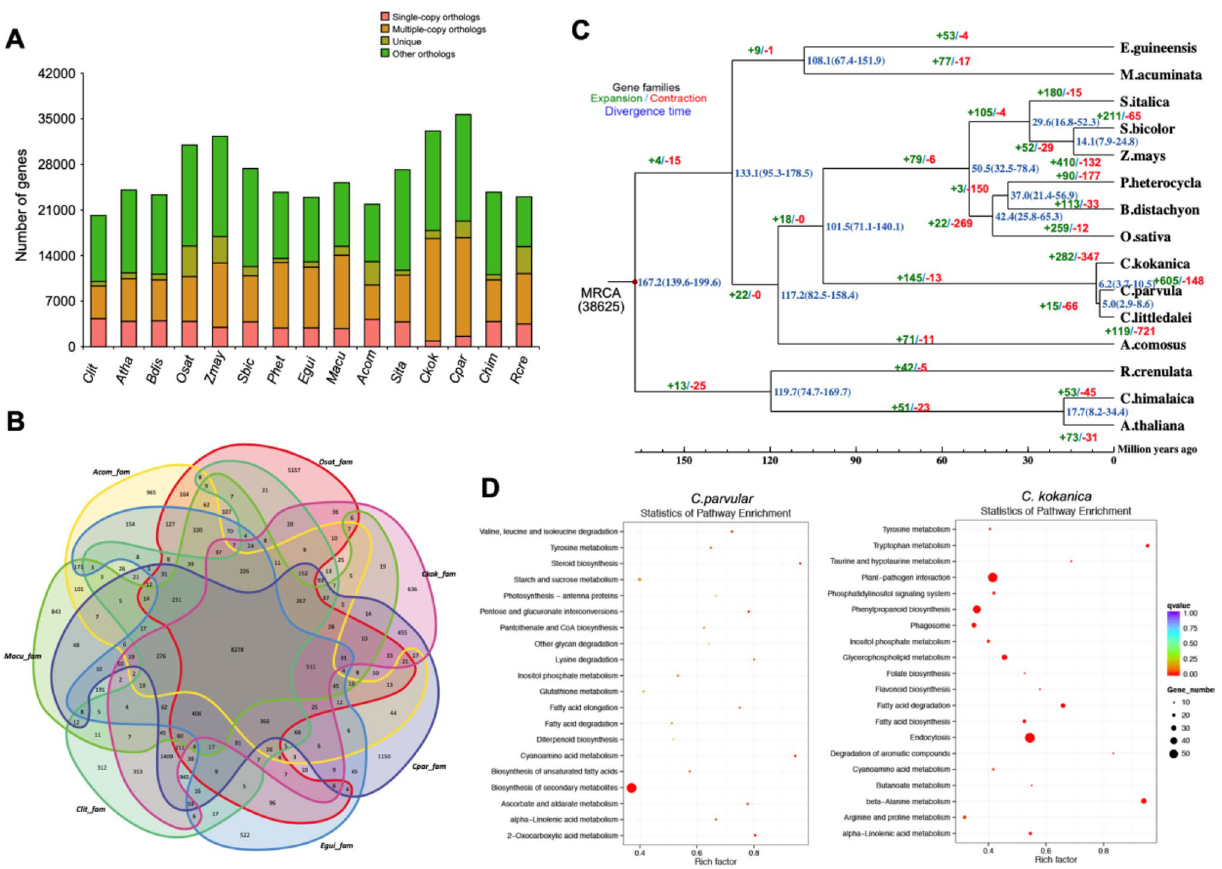
Figure 2. Comparative analyses of Carex parvula and Carex kokanica with other plants. ( A ) The distribution of genes (single-copy genes, multiple-copy genes, unique genes, other and uncluster genes number) in 15 different species. Carex littledalei (Clit), Arabidopsis thaliana (Atha), Brachypodium. Distachyon (Bdis), Oryza sativa (Osat), Zea mays (Zmay), Sorghum. Bicolor (Sbic), Phyllostachys heterocycle (Phet), Elaeis guineensis (Egui), Musa acuminate (Macu), Ananas comosus (Acom), Setaria italica (Sita), Carex kokanica (Ckok), Carex parvula (Cpar), Crucihimalaya himalaica (Chim), Rhodiola crenulate (Rcre). ( B ) Common and unique gene families between Acom, Osat, Macu, Clit, Egui, Cpar and Ckok . ( C ) Gene family expansions and contractions and estimation of divergence time in Carex parvula , Carex kokanica and 13 other species. ( D ) Enriched KEGG terms of the expanded genes of C. parvula and C. kokanica ( K. royleana